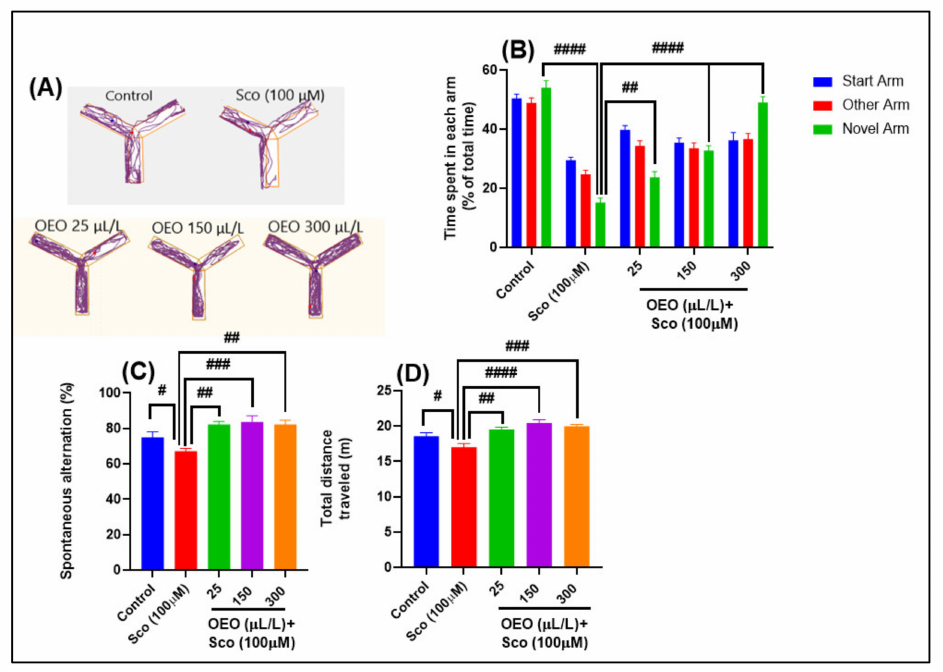
Figure 3. Origanum vulgare ssp. hirtum essential oil (OEO: 25, 150, and 300 µ L/L) improved spatial memory and exploratory behavior in the Y-maze test: ( A ). Locomotion tracking patterns of the control, scopolamine (Sco: 100 µ M), and OEO (25, 150, and 300 µ L/L) treated groups. ( B ). Time spent in each arm (% of the total time) by zebrafish in the tank in different groups; ( C ). Spontaneous alternation (%) in different groups; ( D ). The total distance traveled (m) by zebrafish in the tank in different groups. Values are means ± S.E.M. ( n = 10). For Tukey’s post hoc analyses: # p < 0.01, ## p < 0.001, ### p < 0.0001, and #### p <